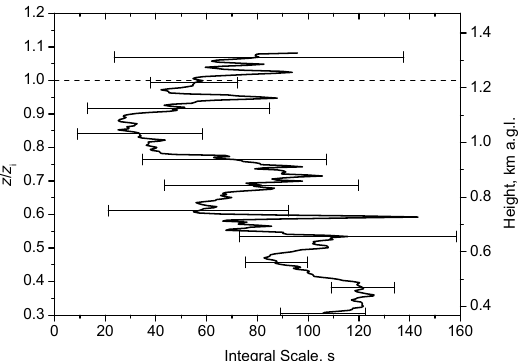
Figure 9. Profile of temperature variance (1h period between 11:00 and 12:00UTC, 24 April 2013). Error bars show the noise errors (thin error bars) and the sampling errors (thick error bars). The mean CBL height z i of 1230m (dashed line) was used for the relative height scale z/z i